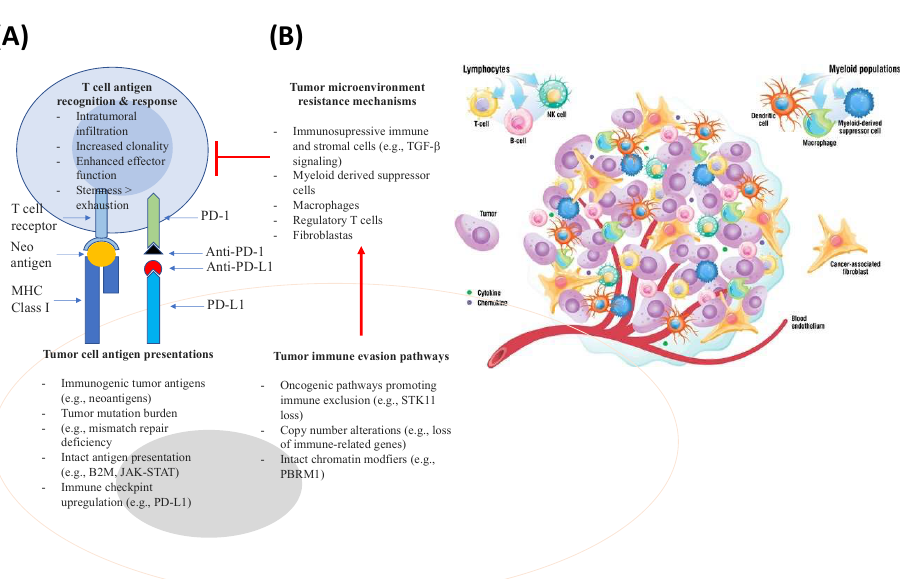
Figure 5. Genomic correlations with response and resistance to ICI therapy within the immune TME. The panel ( A ) represents correlations with response, focusing on antigen presentation and recognition. The panel ( B ) represents resistance pathways that promote tumor immune evasion mechanisms that induce immunosuppressive cells, leading to the inhibition of T cell-mediated anti-tumor response (right side). Adapted from [113]. The panel ( B ) also illustrates the TME, which consists of cellular and non-cellular components. The cellular component consists of cancer cells, endothelial cells, pericytes, carcinoma-associated fibroblasts, and immune cells. The immune compartment comprises many immune cell populations (e.g., T cells, B cells, natural killer cells, tumor-associated macrophages, myeloid-derived suppressor cells, and dendritic cells). The non-cellular component of the TME, on the other hand, is represented by the extracellular matrix and functions as a scaffold. Components of the TME interact via the extracellular matrix, cell-cell contacts, and through the release of cytokines, chemokines, extracellular vesicles, and others. Adapted from ref. [113,184,185]. Definitions of abbreviations are found in the abbreviations list at the end of the text.